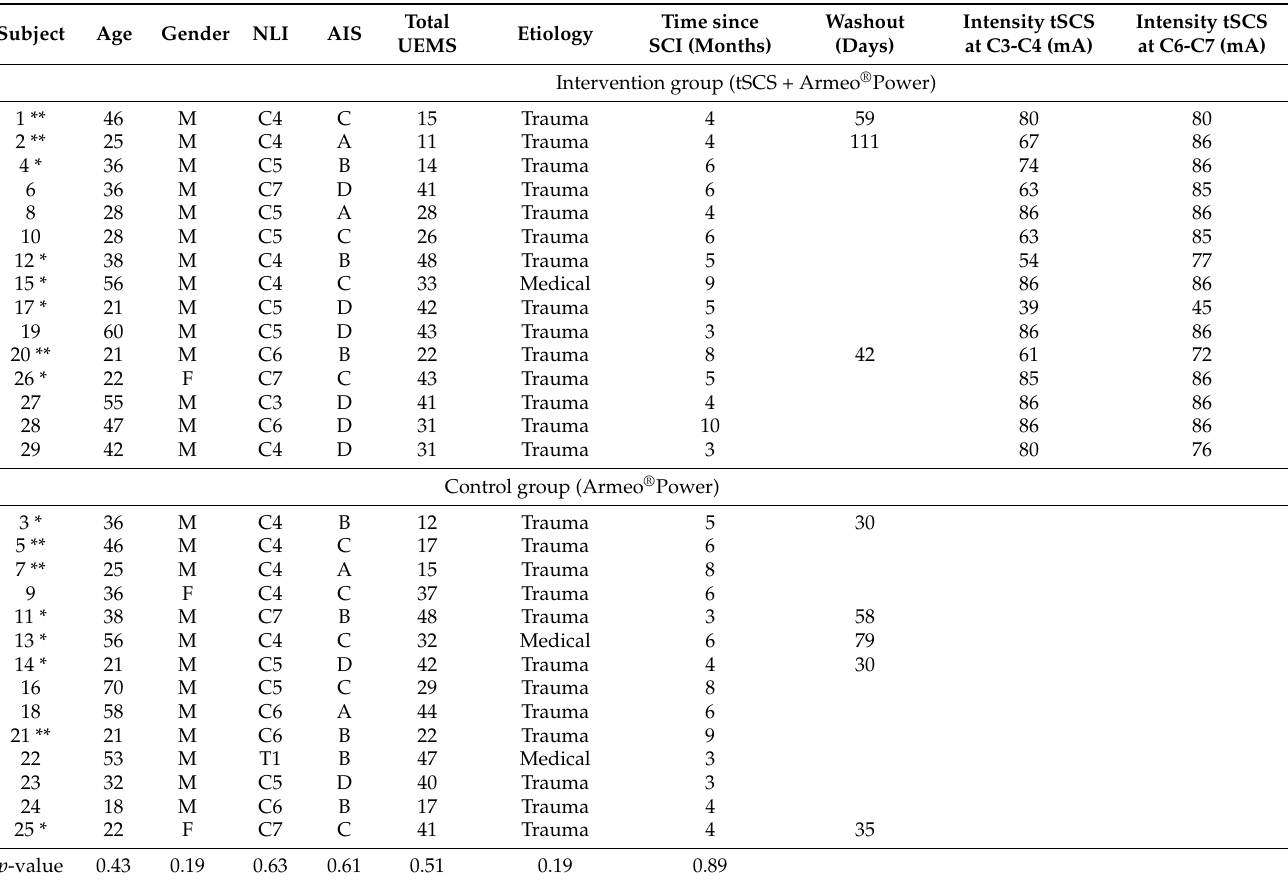
Table 1. Subject’s demographics and clinical characteristics and intensity of stimulation at C3-C4 and C6-C7 vertebral segments. The last two columns consist of the intensity of stimulation of each of the segment levels that received electrical